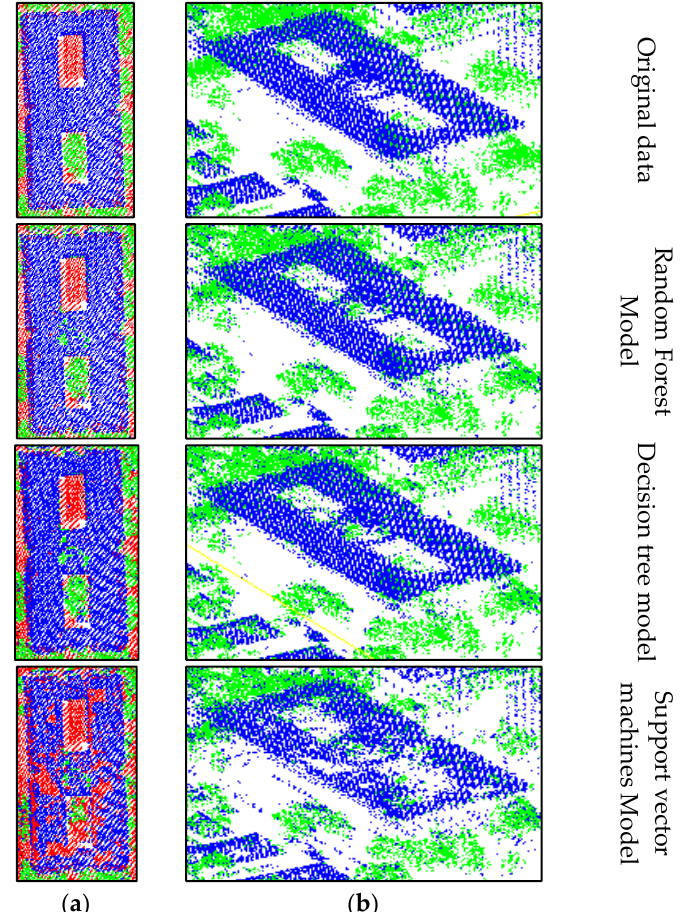
Figure 8. Point cloud classification results of experimental area S_1. ( a ) Top view. ( b ) Side view (buildings and trees).